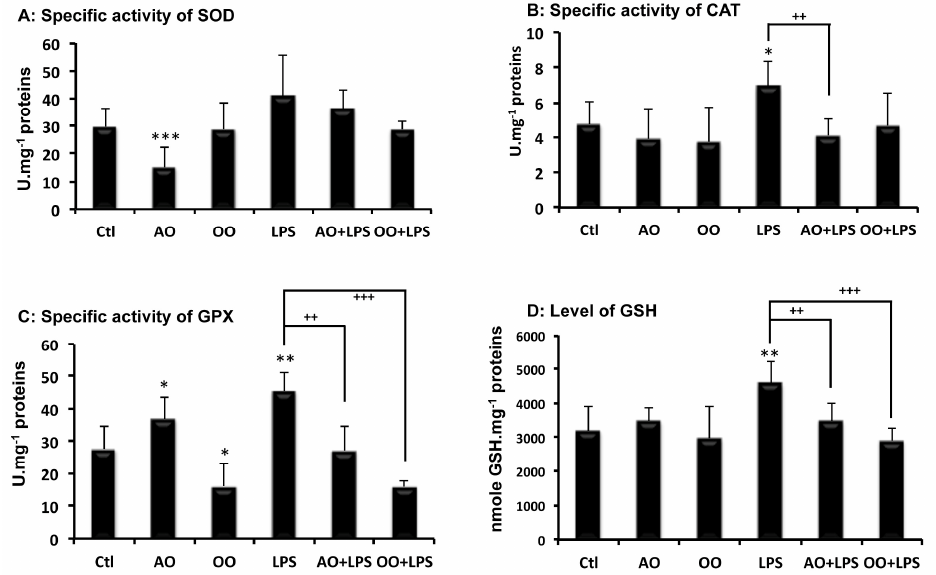
Figure 2. Effects of dietary argan oil and olive oil on mouse liver antioxidant capacities and on their enhancement by LPS. ( A ) Superoxide dismutase (SOD); ( B ) catalase (CAT); ( C ) glutathione peroxidase (GPx) and glutathione (GSH) levels ( D ) Mice received, for 25 days, a standard chow (control: Ctl); a standard chow supplemented with 6% ( w / w ) argan oil (AO) or a standard chow supplemented with 6% ( w / w ) olive oil (OO). Sixteen hours before euthanasia, separate animal groups, given control, AO and OO-supplemented diets, underwent an intraperitoneal injection of 100 µ g LPS (LPS, AO + LPS and OO + LPS groups, respectively). All values are means ± SEM ( n = 6 per group). Statistical significance of higher mean signal intensity (*** p < 0.001, ** p < 0.01, * p < 0.05) compared to control and ( +++ p < 0.001, ++ p < 0.01) compared to LPS.